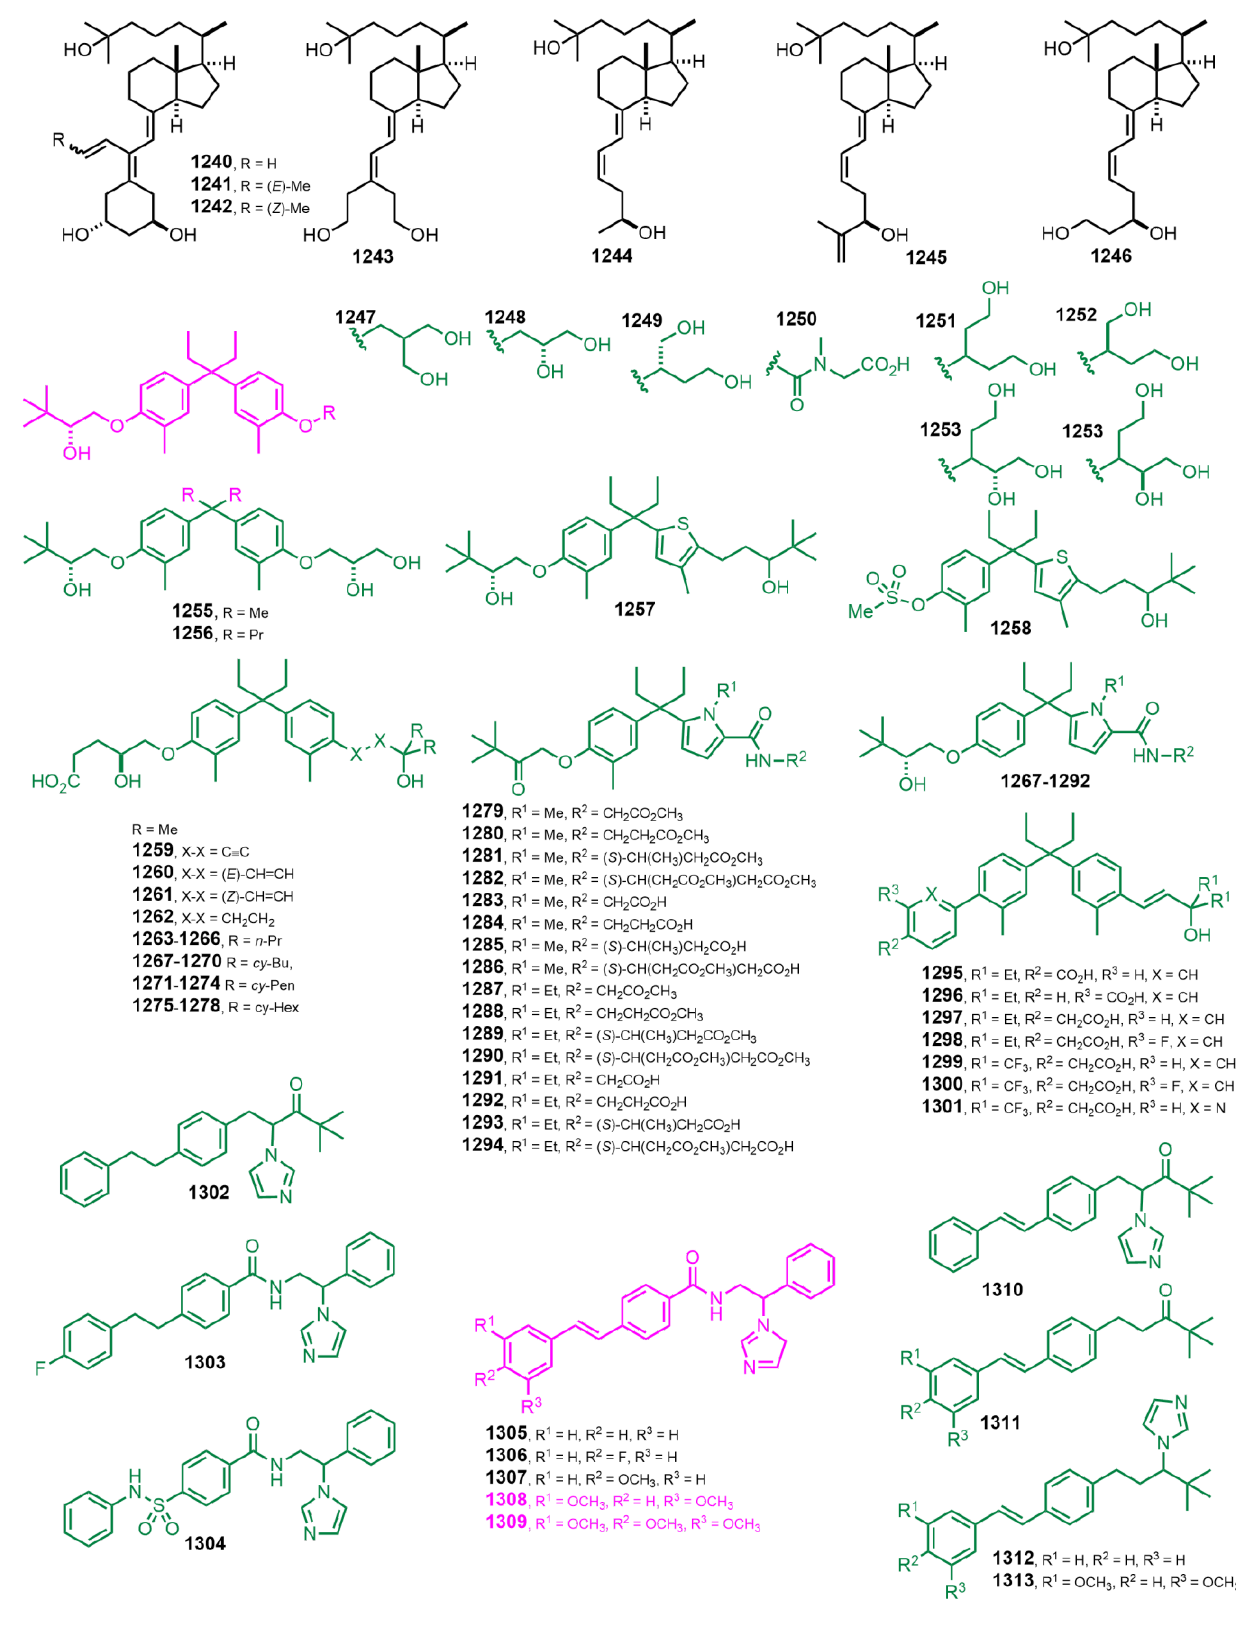
Figure 22. (2013-2014) [313 – 316].